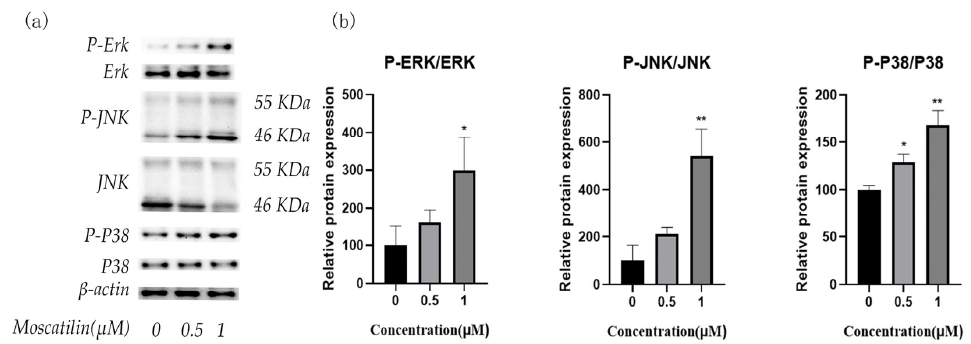
Figure 7. Moscatilin induces apoptosis through the MAPK signaling pathway. ( a ) Western blot as-says were used to detect the protein levels of ERK, P-ERK, JNK, P-JNK, P38, and P-P38, and β -actin was used as a loading control. ( b ) The quantitative results were illustrated for Western blot. * p < 0.05, ** p < 0.01 compared with the 0 µM group.